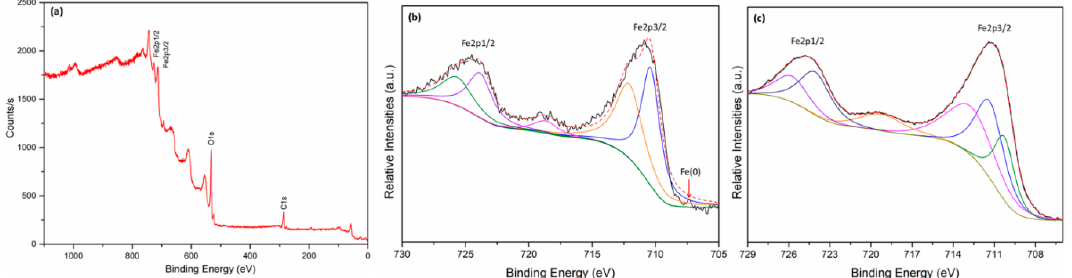
Figure 2. ( a ) Full spectrum X-ray photoelectron patterns of the Fe 0 @Fe 3 O 4 NPs; narrow region X-ray photoelectron patterns of Fe2p for the Fe 0 @Fe 3 O 4 NPs: ( b ) original ( c ) after reaction.